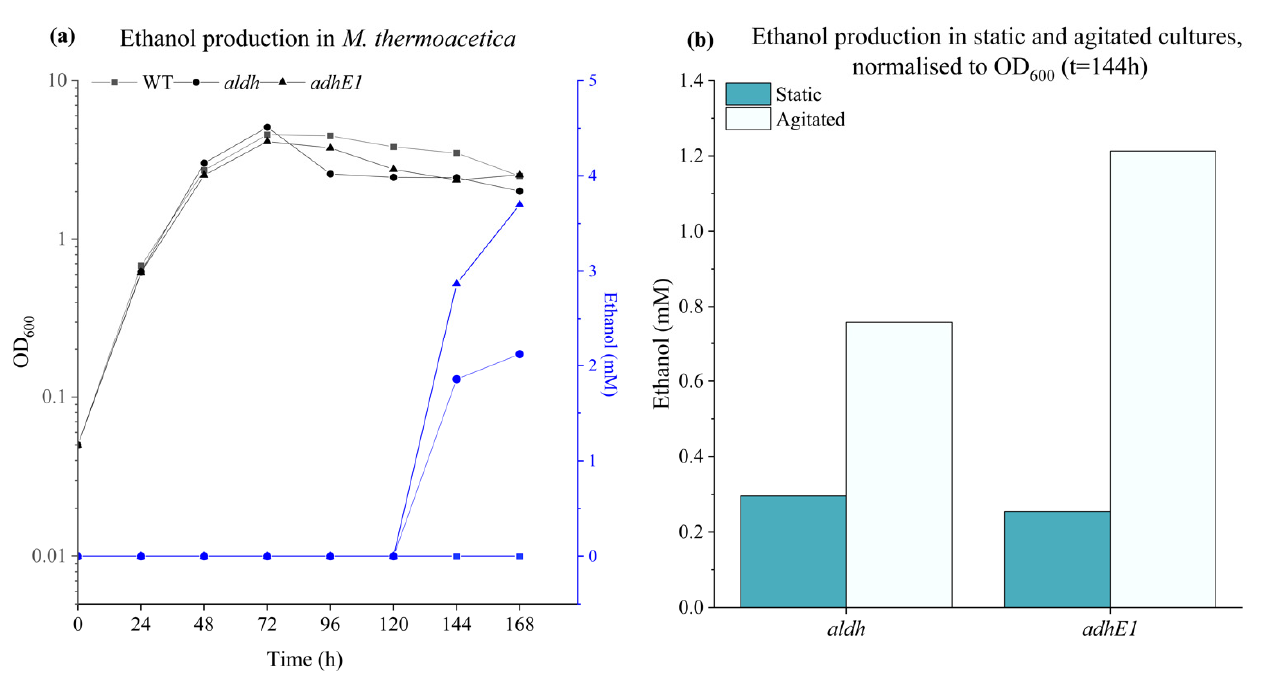
Figure 6. Comparison of ethanol production in M. thermoacetica under different conditions. ( a ) Ethanol production in M. thermoacetica by expressing aldh and adhE1 genes. Ethanol was only detected in the late stationary phase. OD 600 and ethanol concentration (mM) are represented in black and blue, respectively. Square: WT; circle: aldh mutant; triangle: adhE1 mutant ( b ) Ethanol production at t = 144 h in static and agitated M. thermoacetica cultures. No ethanol was detected in the wild-type strain.